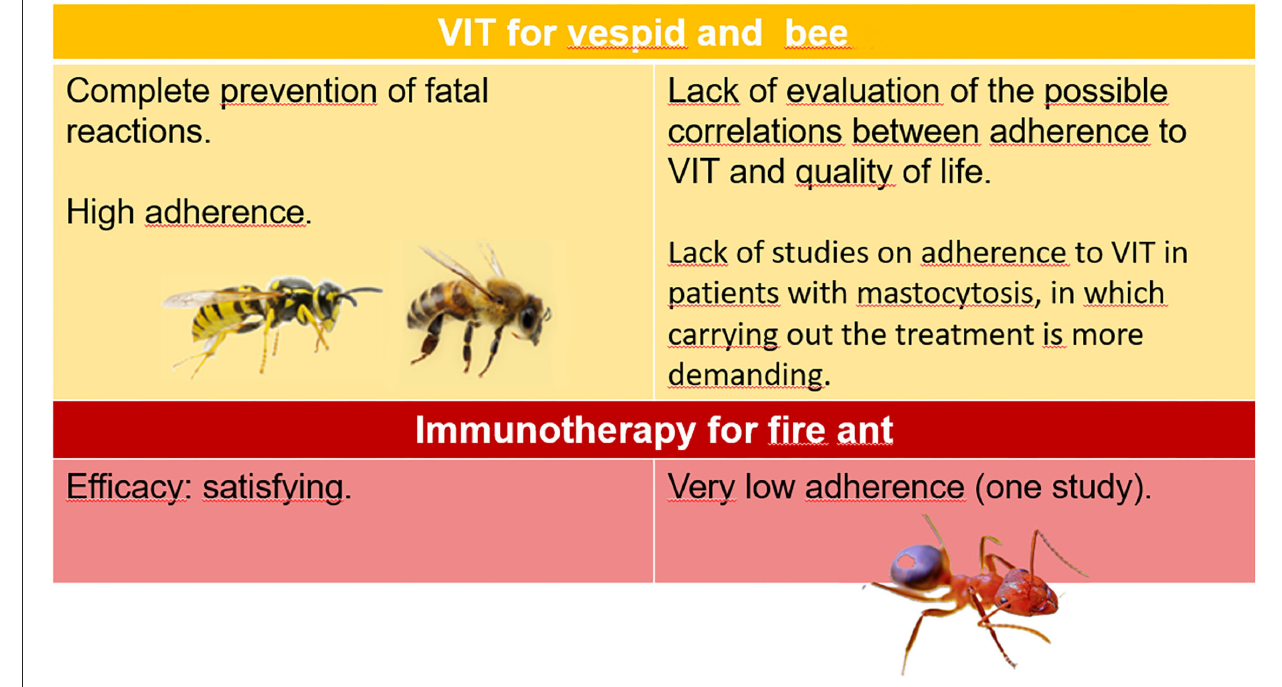
FIGURE 1 | Certainties and shortcomings on adherence to VIT.